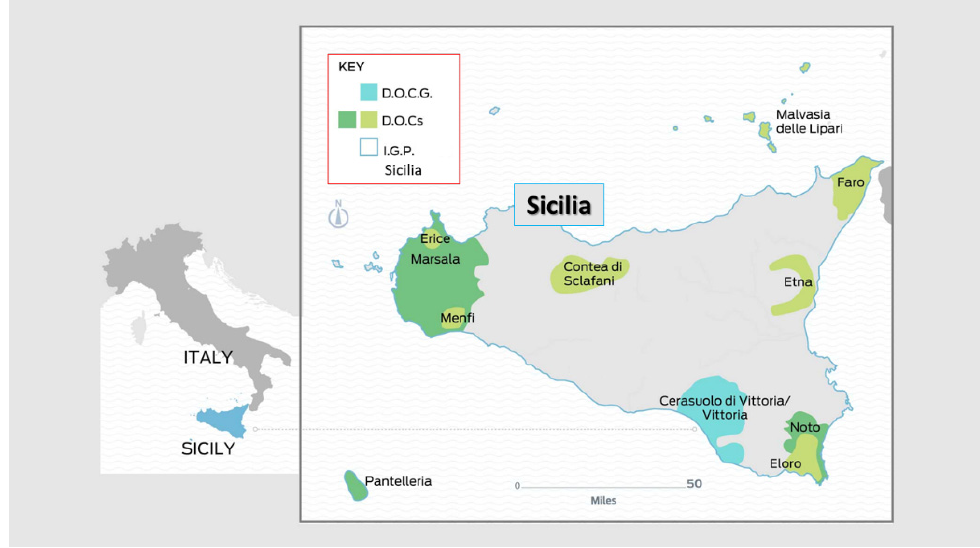
Figure 1. Wine regions of Sicily.